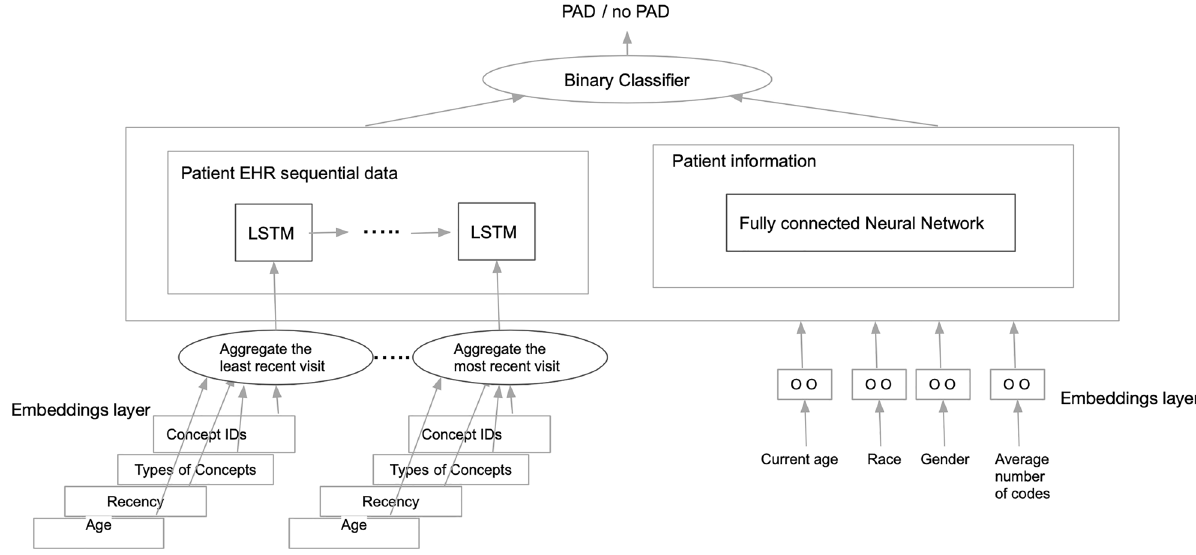
Figure 1. Sequential clinical data and aggregated demographic data are modelled in parallel then combined to make a final classification of PAD versus no PAD in deep learning